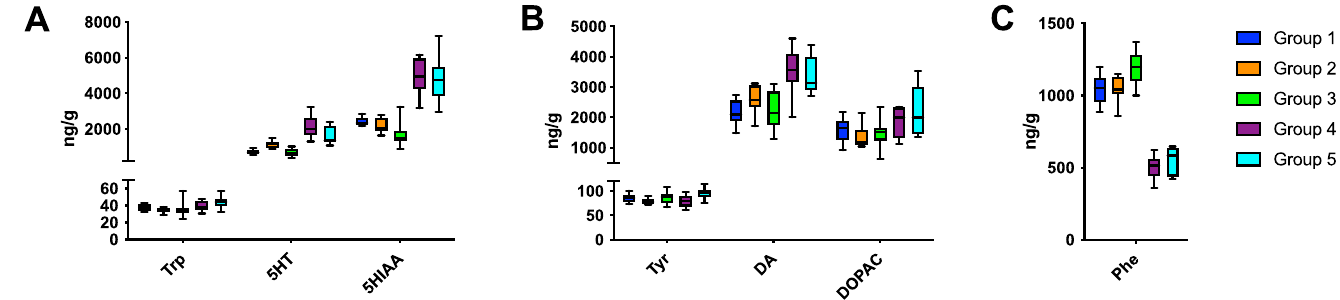
Investigation of the individual brain parts revealed a significant effect compared to control G3(N) for all groups on most brain parts for Phe. G1 (N-CGMP) and G2(N-CGMP-LNAA)